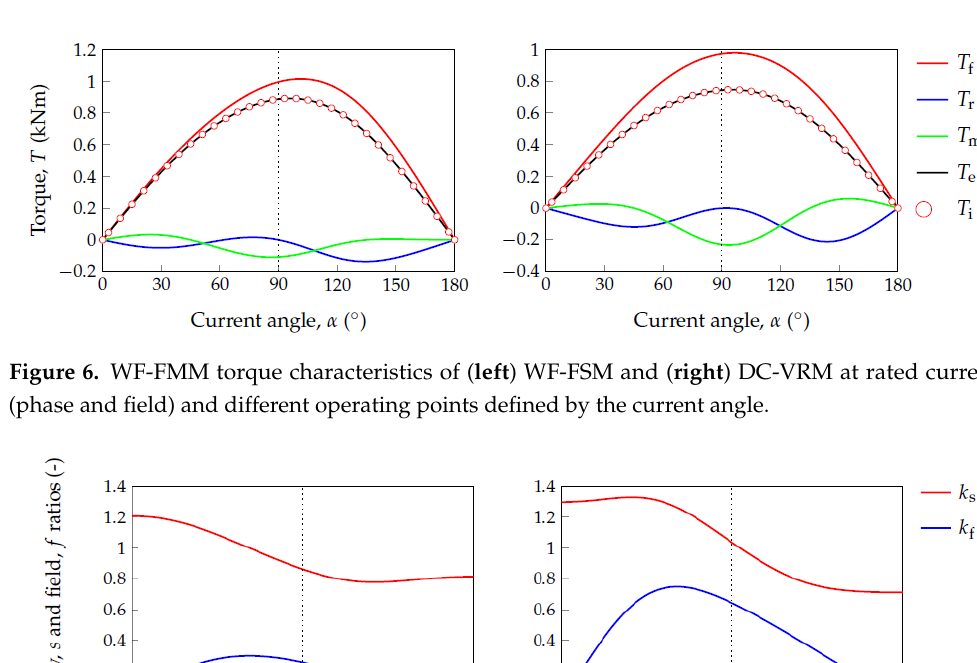
Figure 5. WF-FMM actual inductance characteristics of ( left ) WF-FSM and ( right ) DC-VRM at rated currents (phase and field) and different operating points defined by the current angle.